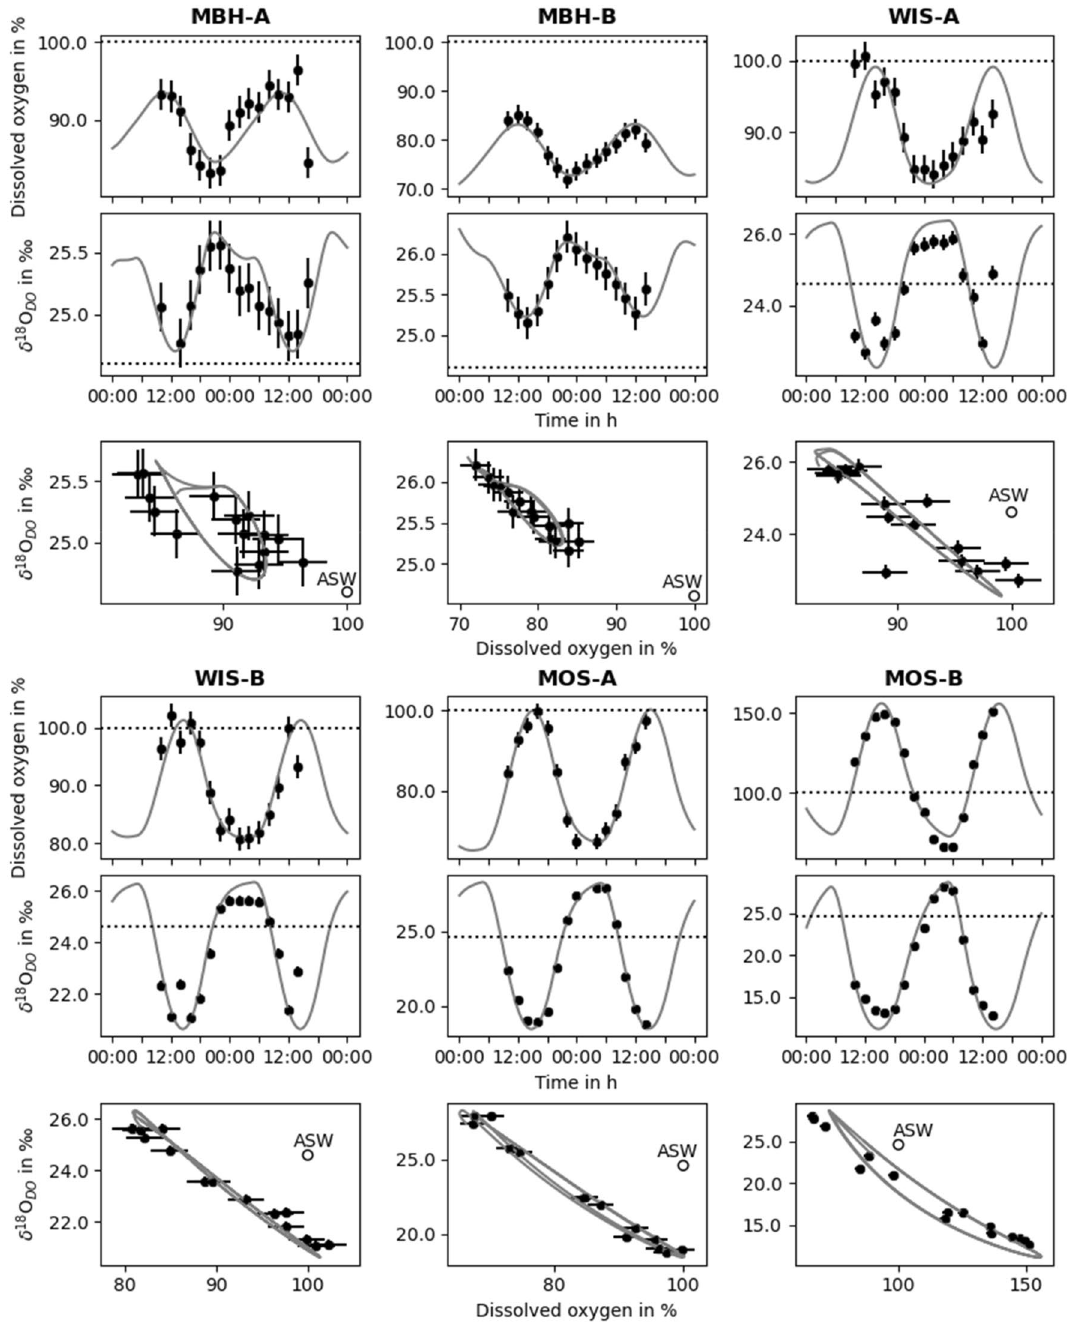
Figure 3. Overview of day–night field data (black dots) and PoRGy model results (grey lines) of dissolved oxygen (DO) saturation and stable DO isotopes ( δ 18 O DO ) at the study sites A (upstream) and B (downstream) of the streams Mähringsbach (MBH), Wiesent (WIS) and Moosach (MOS). Horizontal dashed lines and the empty circle represent air saturated water (ASW) with DO saturation of 100% and a δ 18 O DO value of + 24.6‰. Standard errors for DO saturation and δ 18 O DO are 2% and 0.2‰,